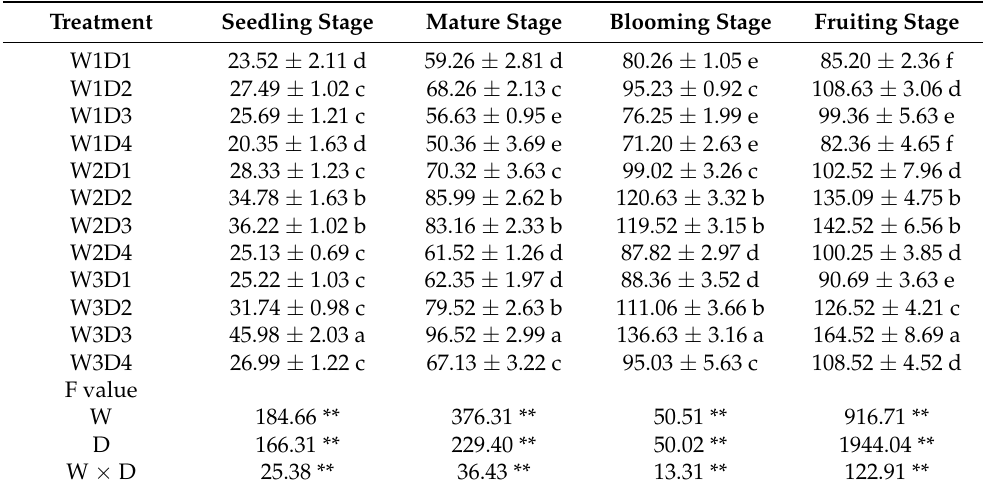
Table 1. Effects of different planting densities and irrigation volumes on the plant height of Suaeda salsa under drip irrigation. Treatment